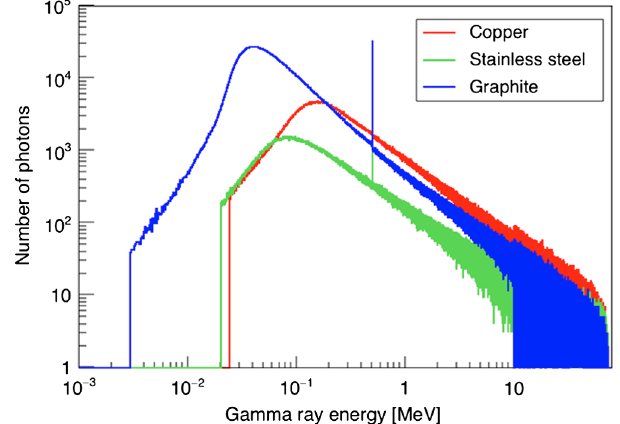
FIG. 11. Temperature change of the 0.1 mm thick Si crystal during a micro-pulse duration of 2 μ s for different beam sizes at the crystal.